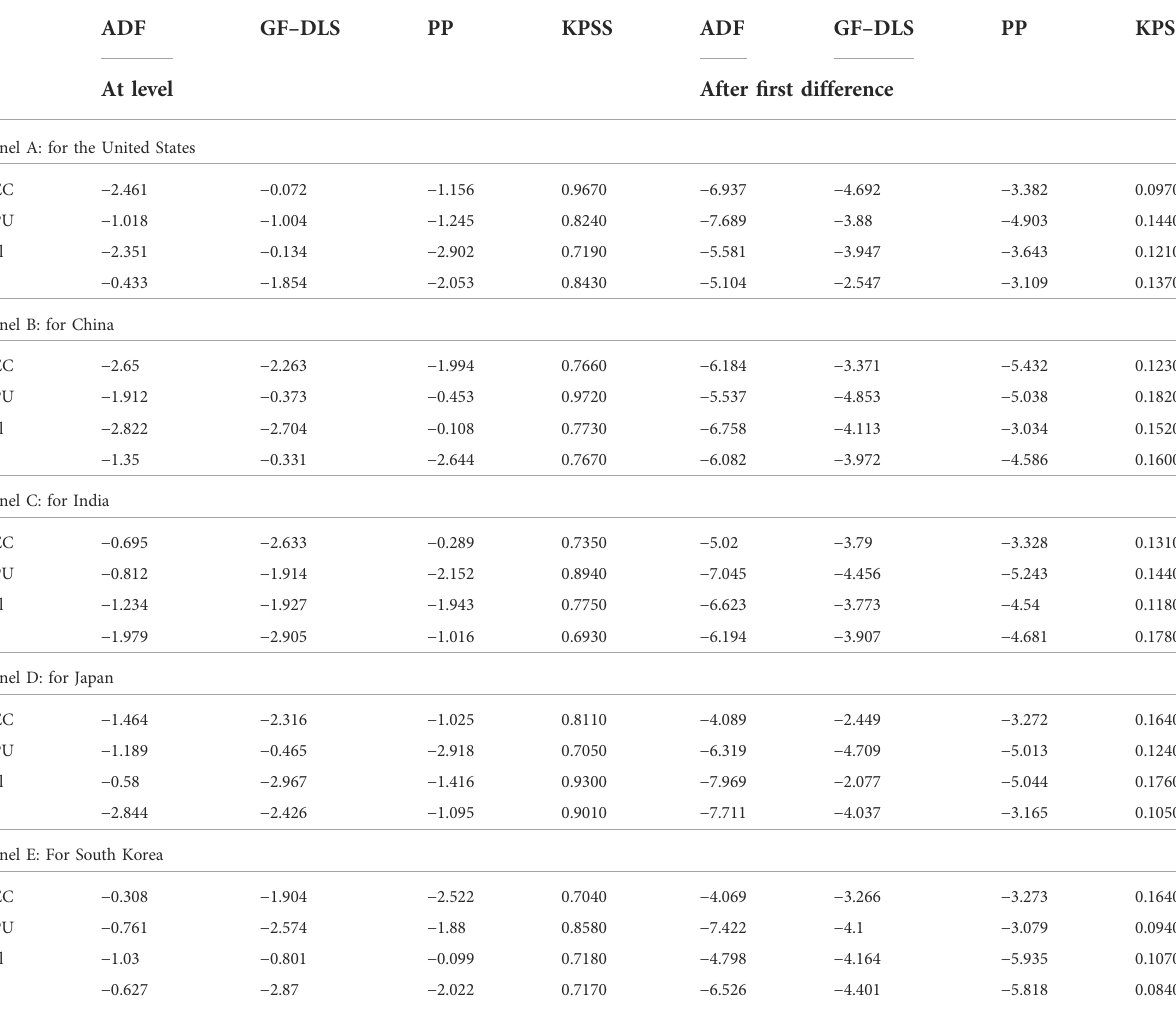
TABLE 3 Results of the unit root test.